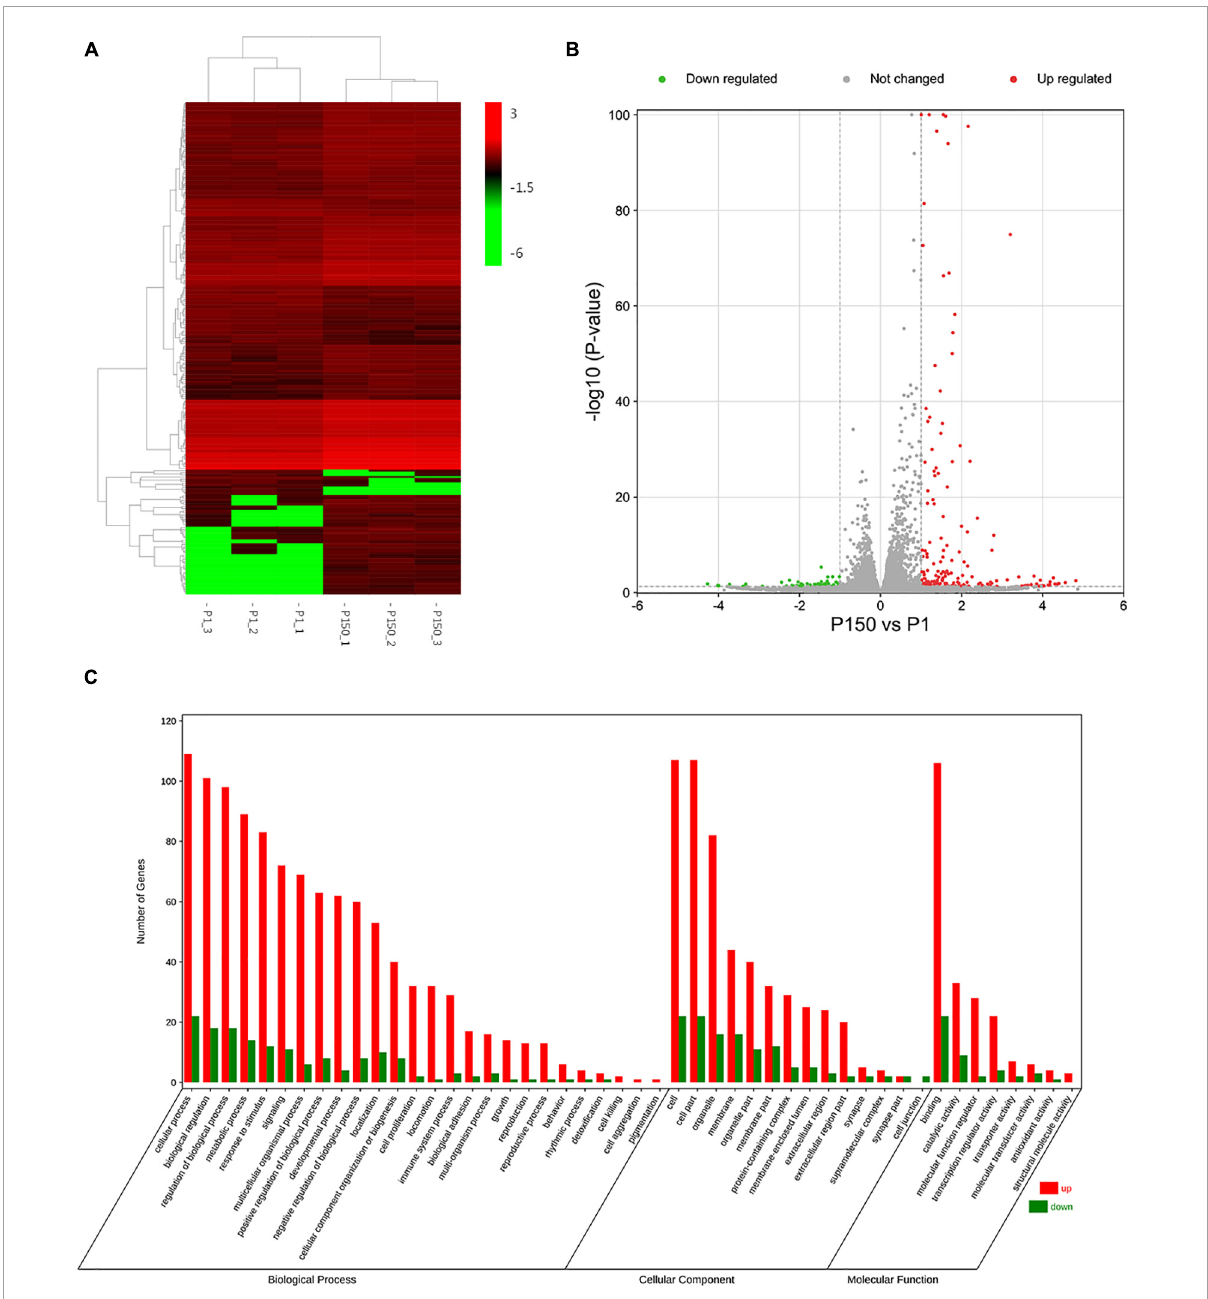
FIGURE2 DEGs analysis of BoMac cell after the P1 and P150 infection. (A) The heat map showed the expression levels of DEGs in the pair of P150 vs. P1. The red color represents the upregulated expression of genes, while the green color represents a downregulated expression of genes. The gradient color barcode at the right top indicates log 2 (FPKM) value. Each row represents a gene and each column represents a sample. (B) Volcano map showed the differential mRNA expression between P150 and P1 (log2FoldChange > 1, p -value < 0.05). (C) Gene ontology (GO) functional classification of upregulated (Red) and downregulated (Green) DEGs. Genes were annotated in three categories: biological process, molecular function, and cellular component. The X -axis means the number of DEGs, while Y -axis represents GO terms.